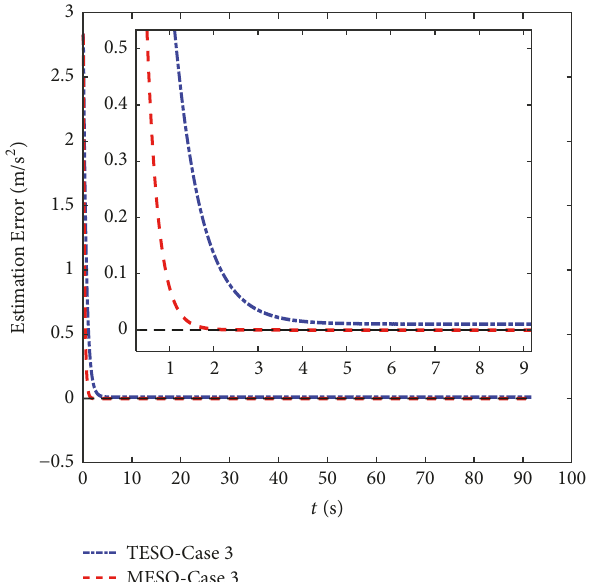
Figure 13: Estimation error of the total